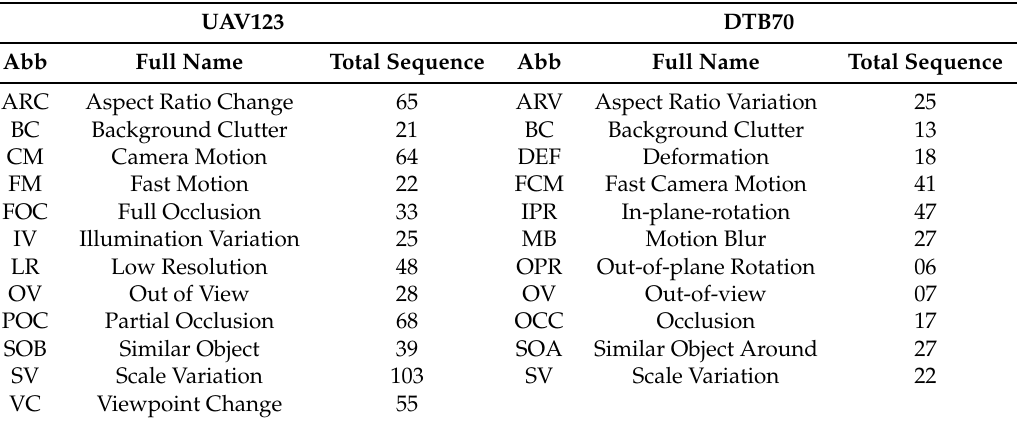
Table 1. Dataset